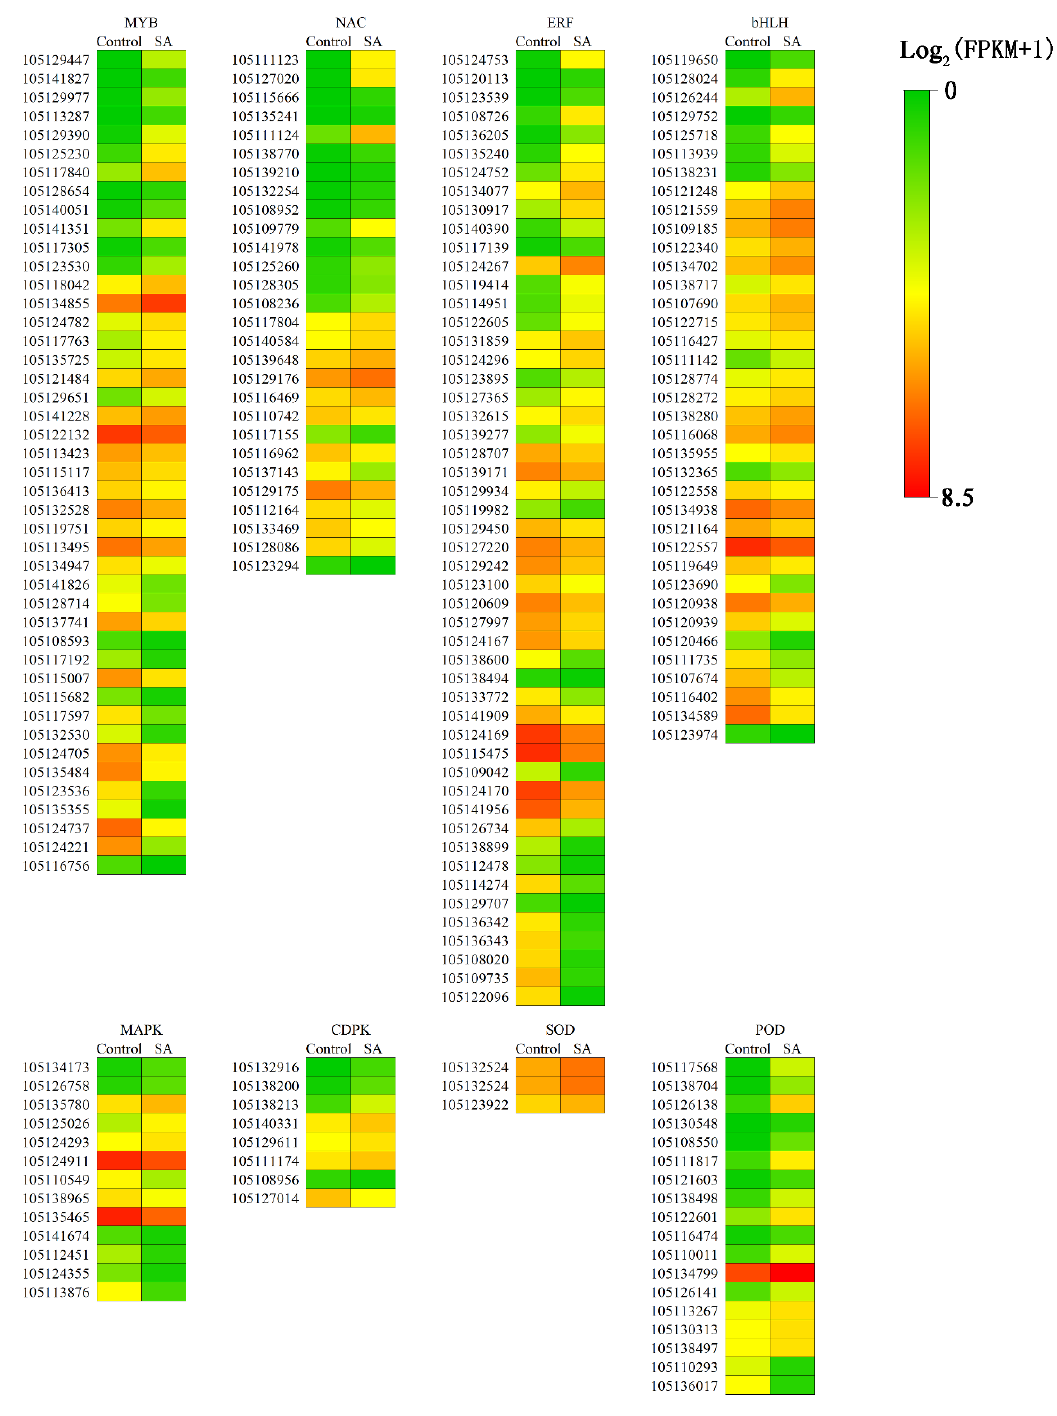
Figure 7. Expression profiles of differentially expressed genes regulated SA to alleviate salt tolerance. Data represent the mean ± SD (Standard Deviation) of three independent experiments. The heat map of each related protein and transcription factor family is represented by the log 2 (FPKM + 1) of Control check and SA. Here, the FPKM means fragments per kilobase of transcript per million mapped reads. The range of all values varies from 0 to 8.5. The greener is closer to the minimum value, and the red is closer to the maximum value. The gene ID is on the left side.